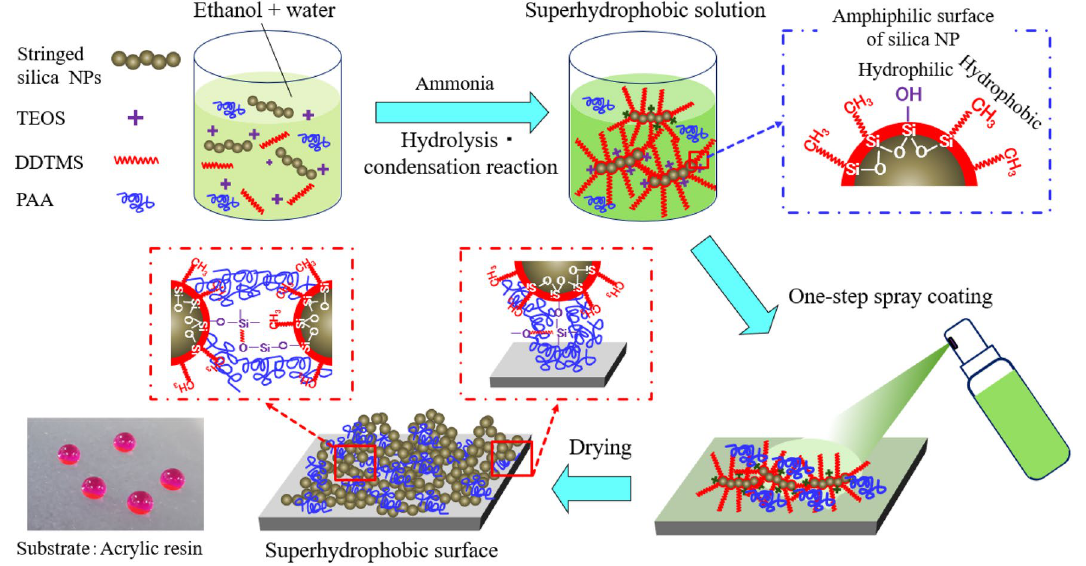
Fig. 1 Schematic illustration of the fabrication of transparent, robust and environmentally friendly superhydropobic surfaces by a one-step spray coating